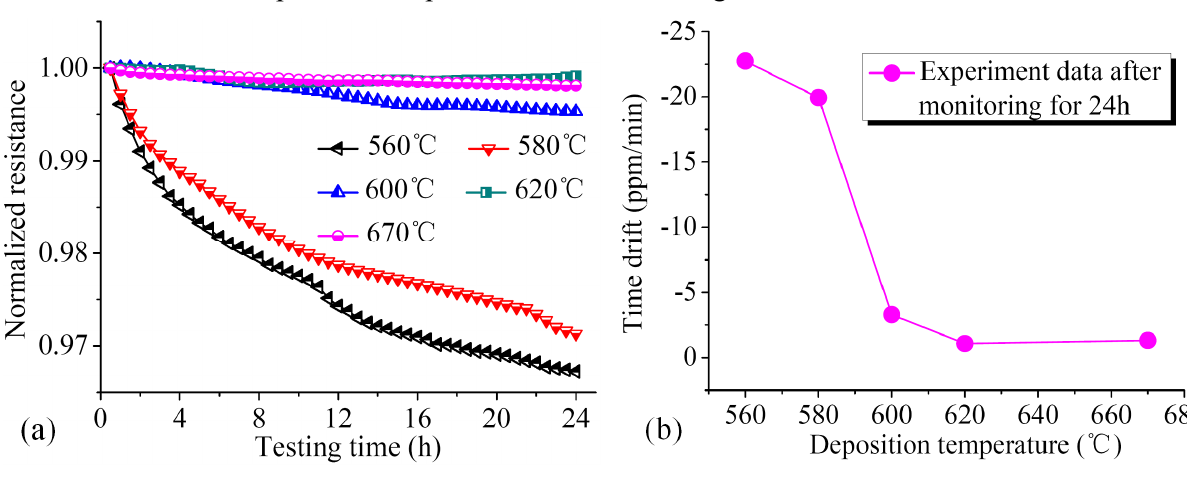
Figure 16. (a) Normalized resistances of PSNF piezoresistors with different deposition temperatures as a function of testing time during monitoring for 24 h. (b) RTD of PSNF resistors versus deposition temperature after monitoring for 24